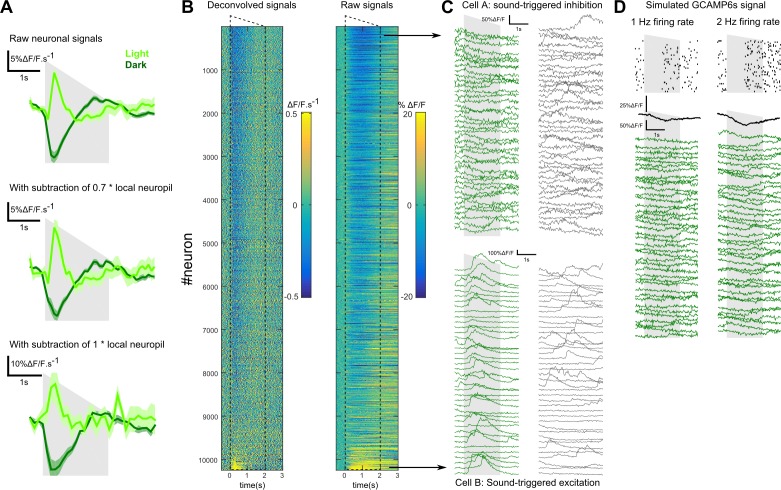
Robust inhibition in response to sounds in V1.(A) Mean V1 population responses to a down-ramping sound in lit and dark conditions measured without neuropil subtraction (top), or with the conventional neuropil subtraction (factor 0.7 applied to neuropil signal, middle) or with a larger correction (factor 1 applied to neuropil signal, bottom). In all cases, a clear decrease in fluorescence is observed in the dark. (B) Heat map showing the deconvolved and raw calcium signal responses to the down-ramp for all recorded V1 neurons. Inhibition is observed robustly across cells. (C) Single-trial, raw calcium signal responses to a down-ramp (left) and spontaneous activity (right) for a cell inhibited (top) and another excited by the sound (bottom). The inhibition corresponds to both a decrease in fluorescence and a decrease in the occurrence of spontaneous positive calcium events. (D) Simulations of GCAMP6s ΔF/F signal for Poisson spike trains at 1 Hz and 2 Hz (see on top raster plots for 40 instantiations), with a 1 s period where all spikes are removed (inhibition). In the simulation, each spike produced a transient of peak amplitude ΔF/F = 10% and modeled as a difference of exponentials with rise and decay time constants of 70 ms and 1870 ms respectively. All parameters are derived from Deneux et al. (2016a). All transients were summed (convolution of the spike train with the single spike kernel) and Gaussian white noise (5% standard deviation) was added to produce the simulated calcium traces. The plots, for the 40 spike trains shown on the top, show that a 1 s firing pause during a low Poisson firing rate yielded trial-averaged (black trace) and single-trial traces highly compatible with inhibition traces observed in vivo, for example in C. Thus, inhibitory responses observed in calcium signals from V1 neurons could result from the downward modulation of a low, basal firing rate (of the order of 1 Hz) in each cell commonly observed in awake cortex (Hromádka et al., 2008).